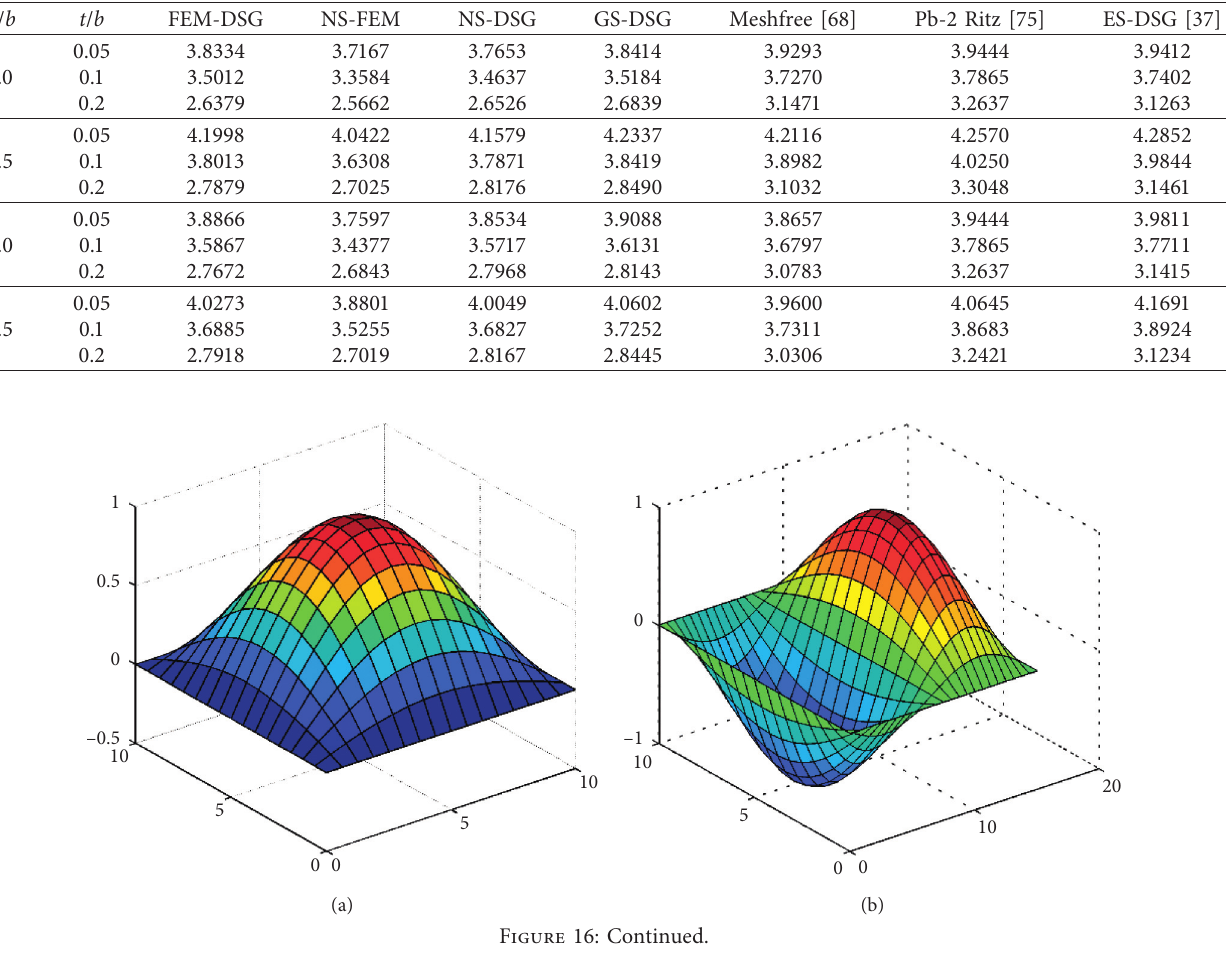
Figure 15: The buckling modes of the simply supported square with different types of edge loading: (a) axial compression; (b) biaxial compression; (c) shear in-plane. Table 10: The factor K of axial buckling loads along the x axis of rectangular plates with various length-to-width ratios and various thickness-to-width